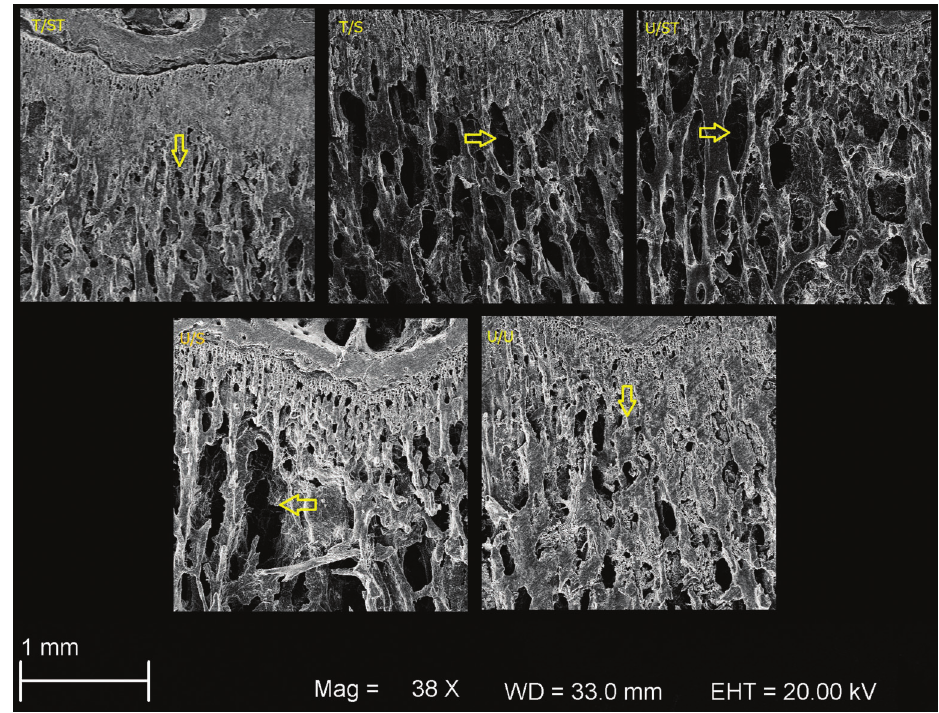
Figure 7. Scanning electron microscopy showing comparative bone micro-architecture. Arrows indicate trabecular space. T/ST: trained/ suspended + trained rats; T/S: trained/suspended rats; U/ST: untrained/suspended + trained rats; U/S: untrained/suspended rats; U/U: